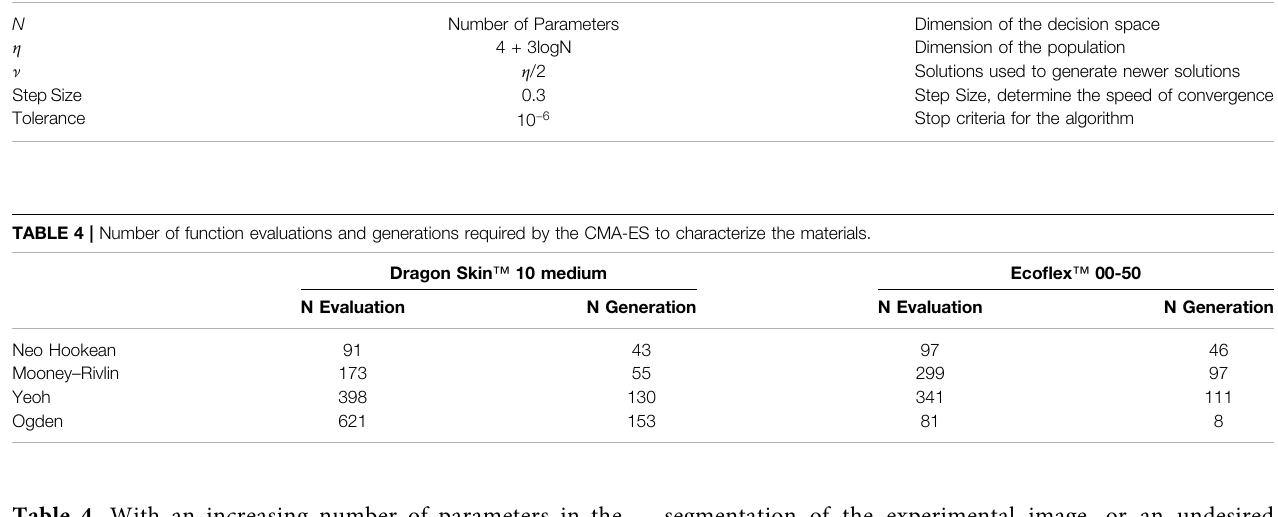
Table 4 . With an increasing number of parameters in the material model, the table displays the growth in the number of